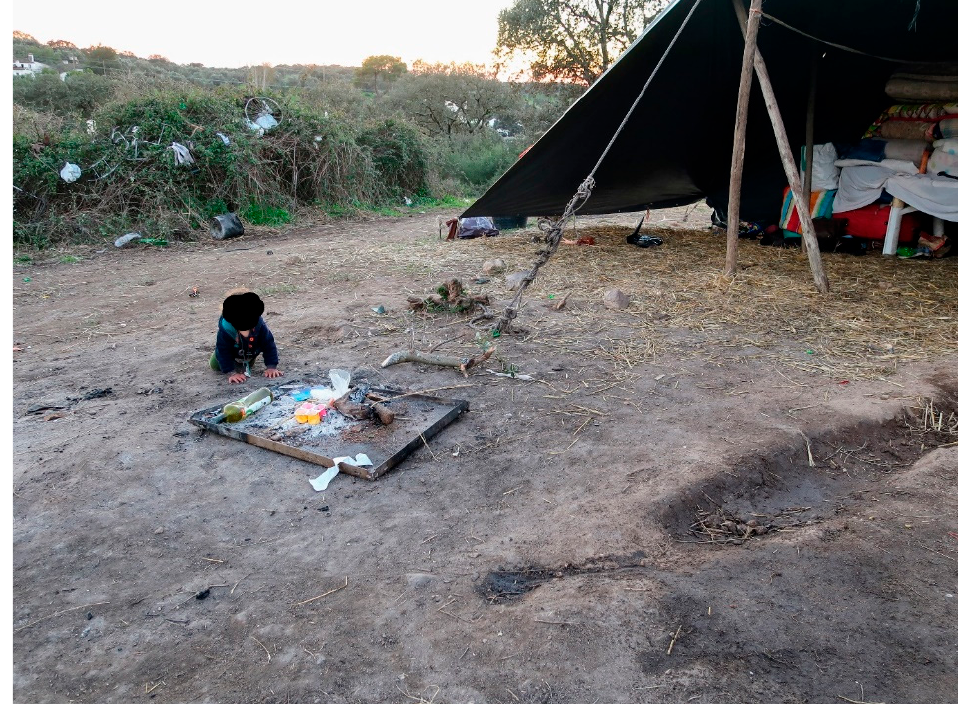
Figure 2. Cigano Camp. Photograph by Fernando Moital. January 2022.